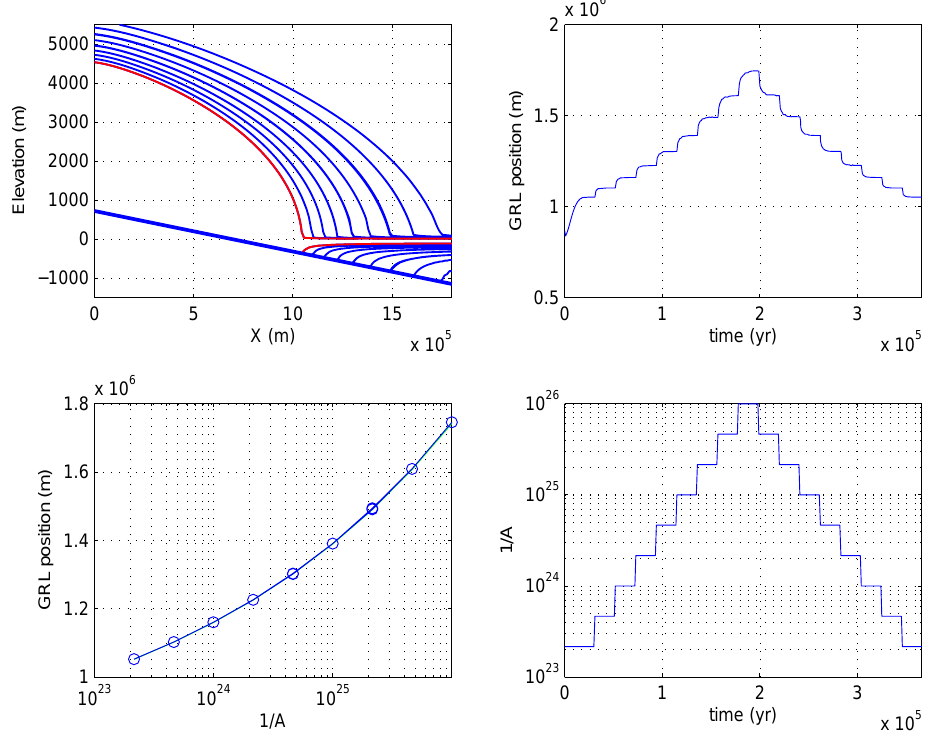
Fig. 1. Results of EXP 1 and 2 performed with a participating FGH model (Docquier et al., 2011) with 1x = 12 . 5km. The different panels show the steady state ice sheet profiles (EXP 1 = advance, EXP 2 = retreat – note that the profiles of both advance and retreat overlap) with the red profile the final profile at the end of EXP 2, the position of the grounding line in time, steady state grounding line positions as a function of the forcing viscosity ( A − 1 ), and the forcing of A − 1 over time.